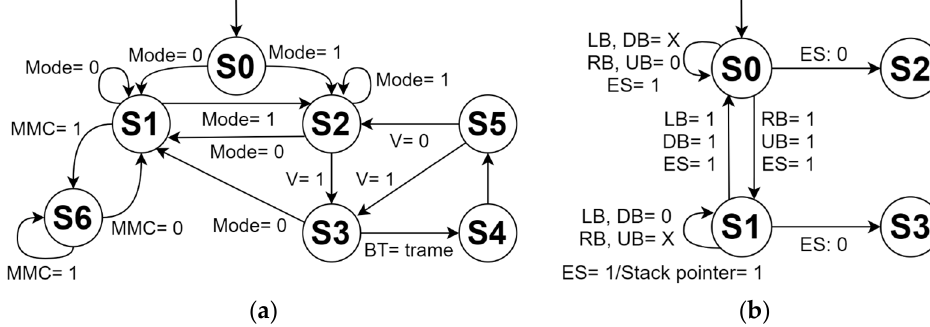
Figure 5. Finite-state machine of the ( a ) operation and ( b ) control panel mode of the automated mechanical system. Table 1. Transition states of the finite-state machine for the automated mechanical system. Table 2. Inputs and outputs of the operation of the automated mechanical system.